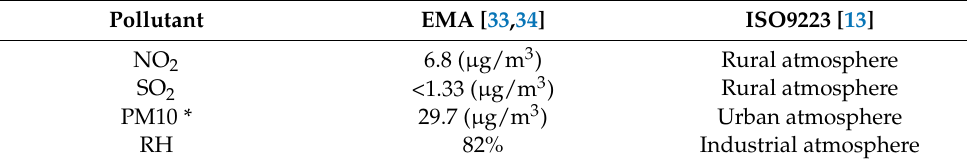
Table 3. Annual mean